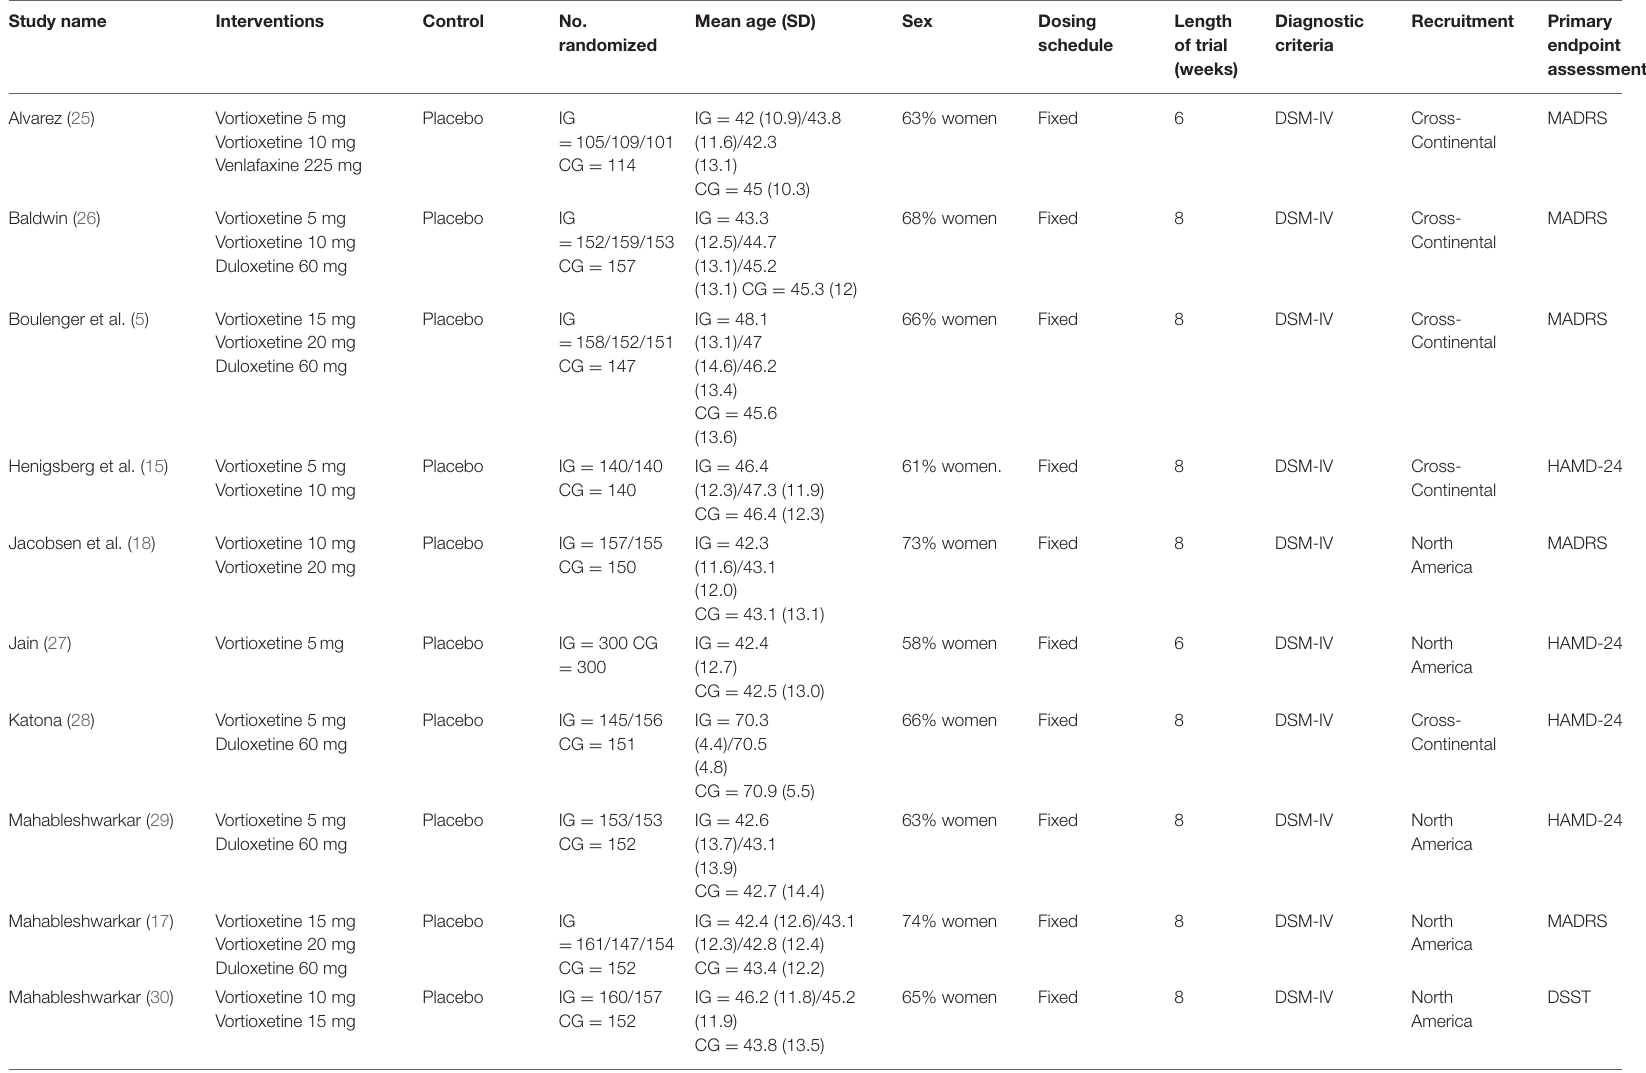
TABLE 1 | Characteristics of included